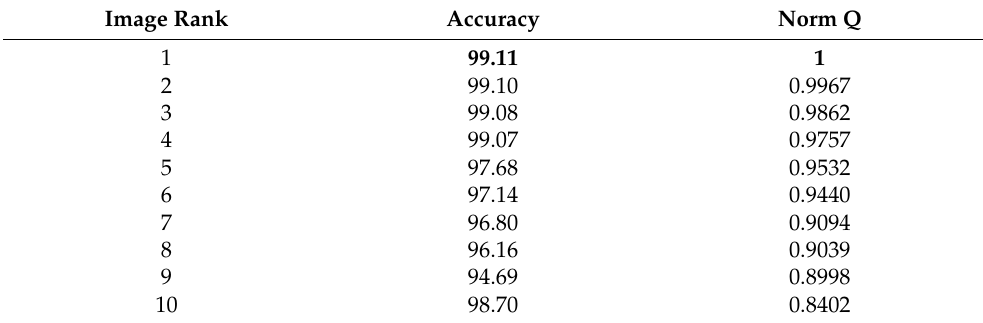
Table 3. Normalized Q and OCR Accuracy results for the Best Image Array of document D1 .